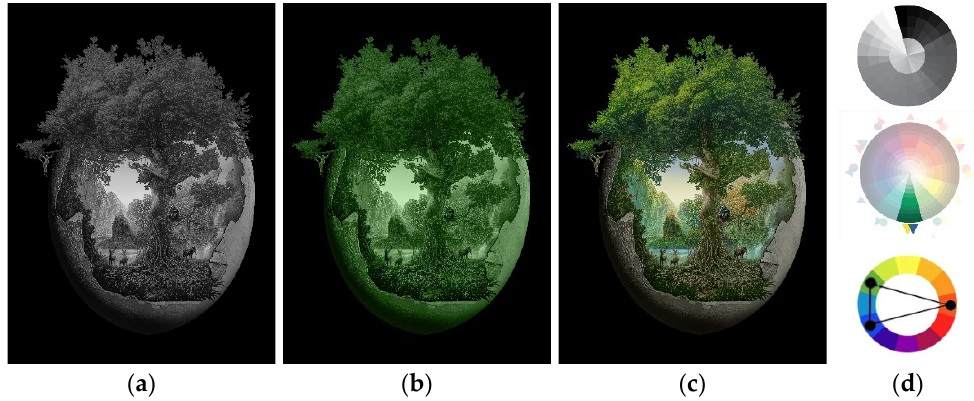
Figure 5. The artwork depicts a fertile environment inside a cracked eggshell where all creatures coexist harmoniously: ( a ) Black ‐ and ‐ white concept; ( b ) Monochrome concept; ( c ) Color concept; ( d ) coexist harmoniously: ( a ) Black-and-white concept; ( b ) Monochrome concept; ( c ) Color concept; Color wheel concept of each image. ( d ) Color wheel concept of each